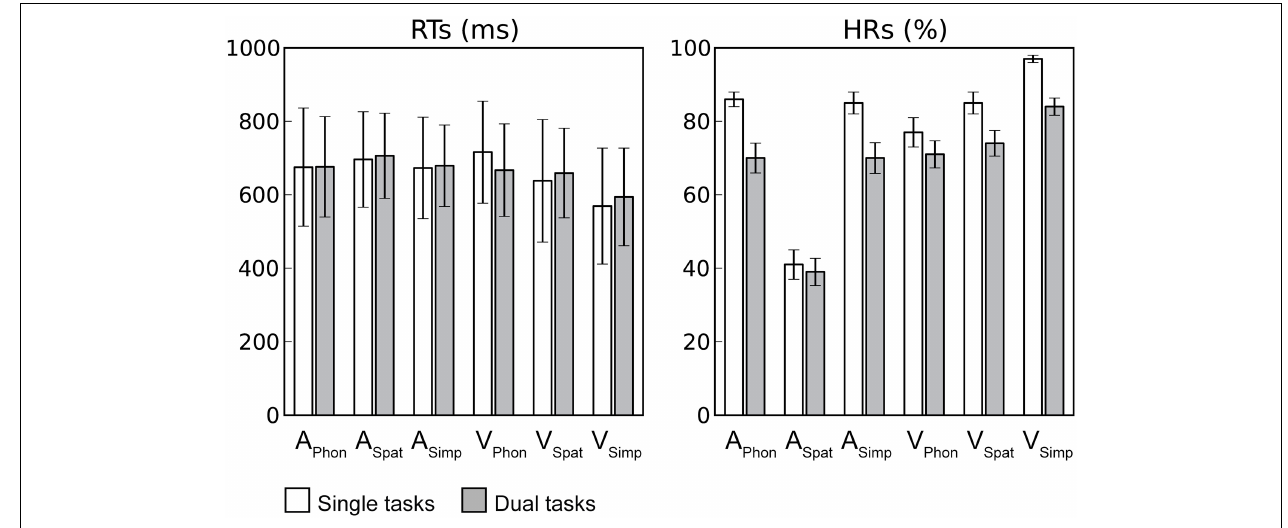
FIGURE 2 | Task performance. Mean reaction times (RTs; includes only hit responses) and hit rates (HRs) during single (white columns) and dual (gray columns) task conditions for each auditory and visual component task. Error